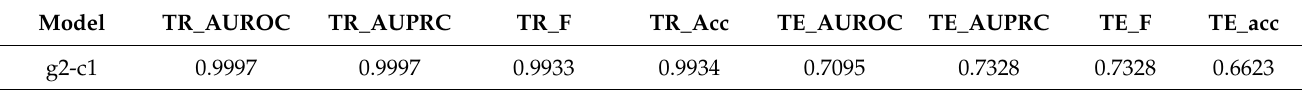
Table 5. Best multi-view random forest model trained on combined clinical and genetic